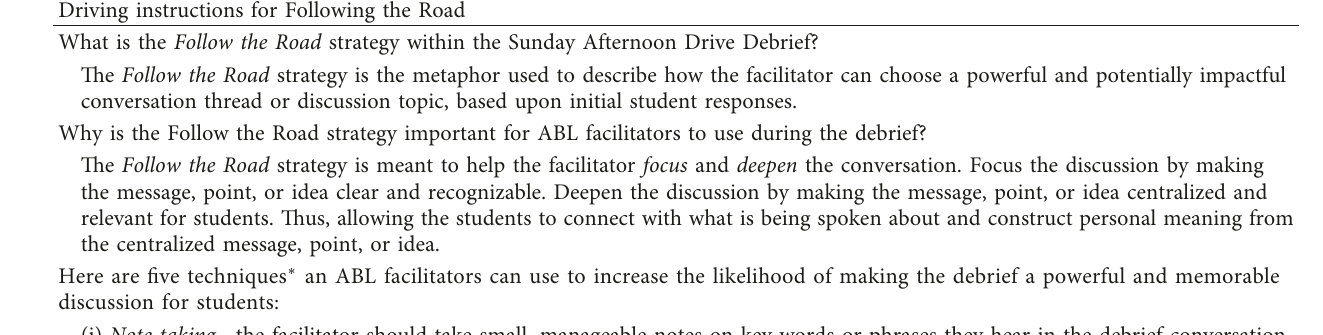
Table 2: Driving instructions for Following the Road (Supplement for the Sunday Afternoon Drive Debrief Model). Driving instructions for Following the Road What is the Follow the Road strategy within the Sunday Afternoon Drive